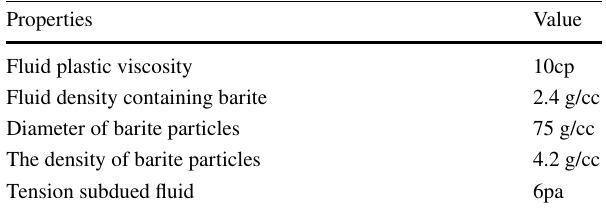
Table 2 Fluid properties